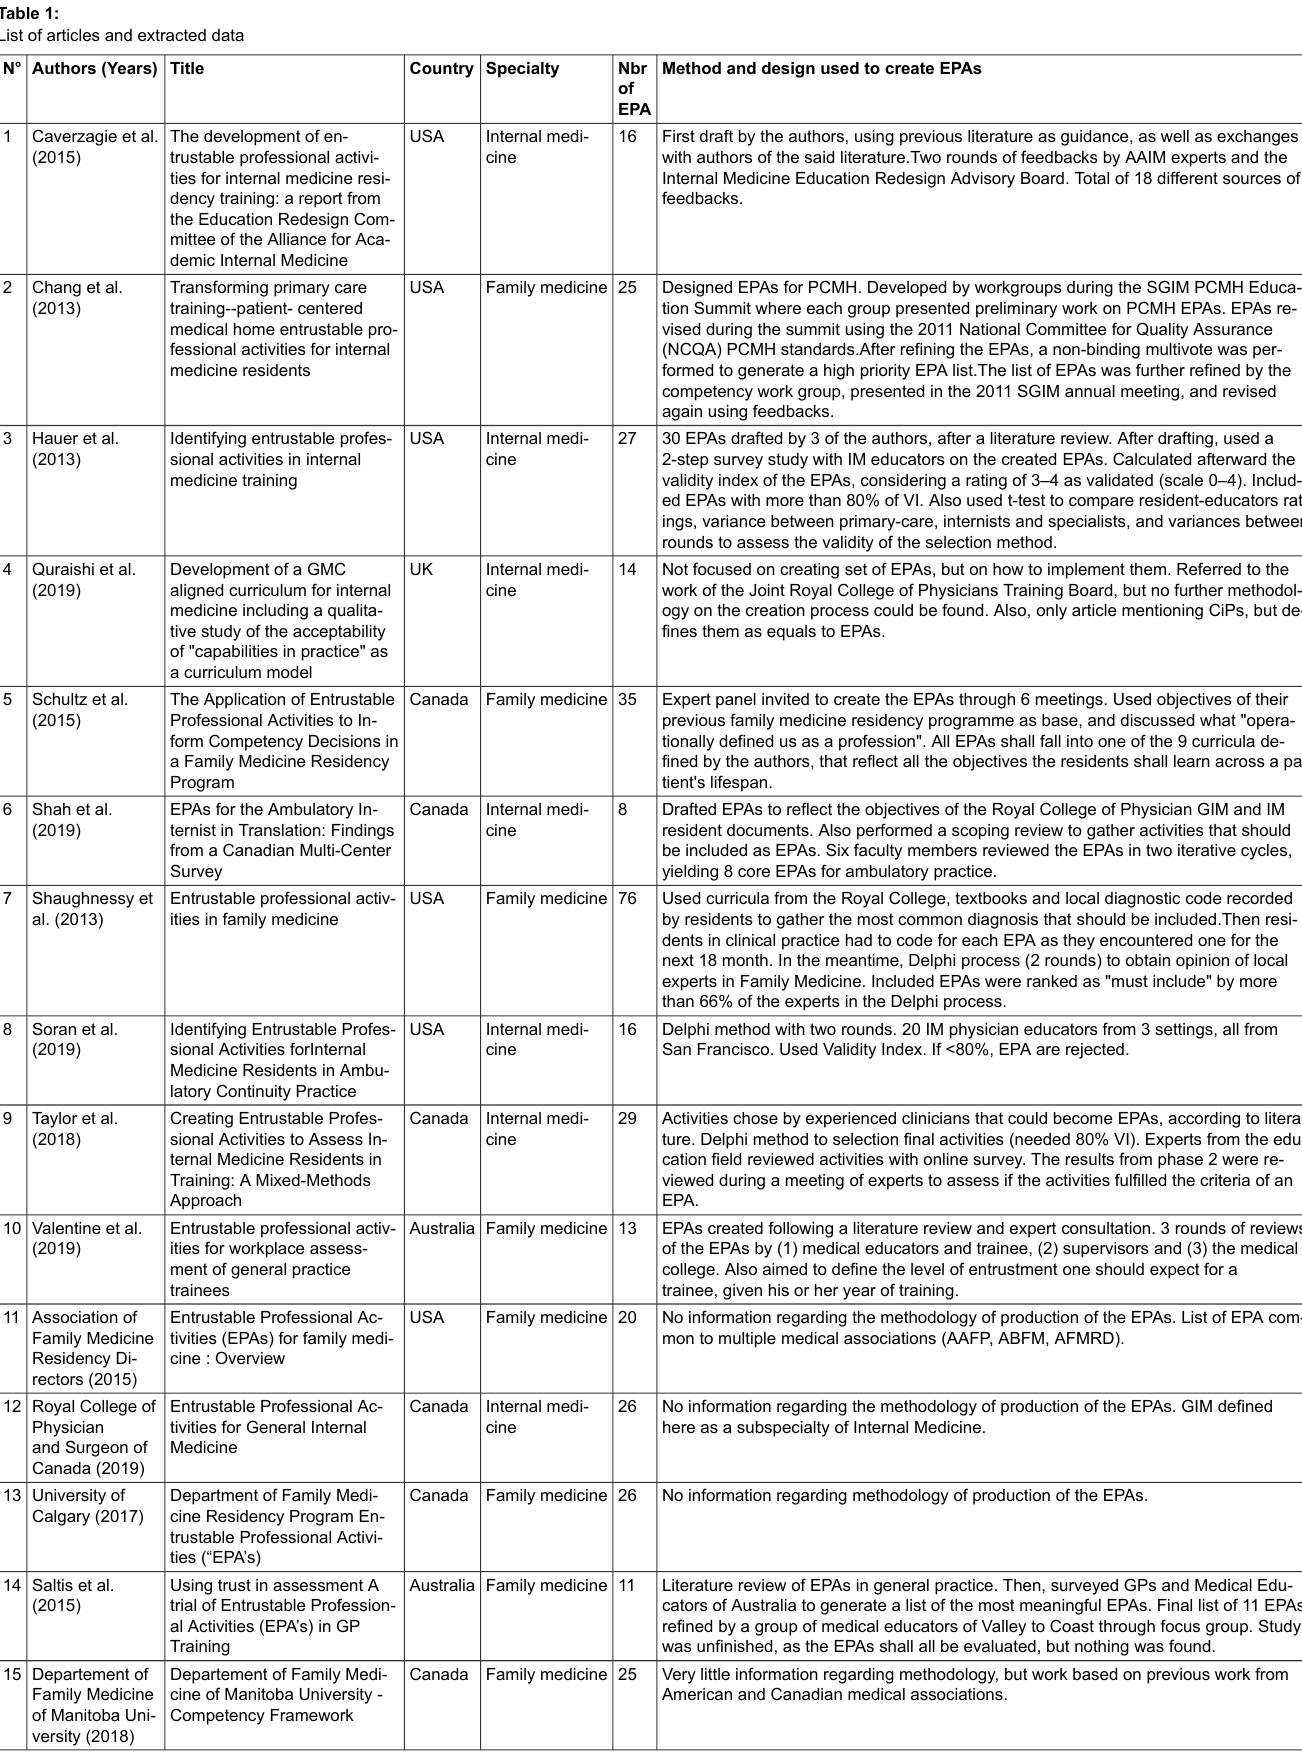
Table 1: List of articles and extracted